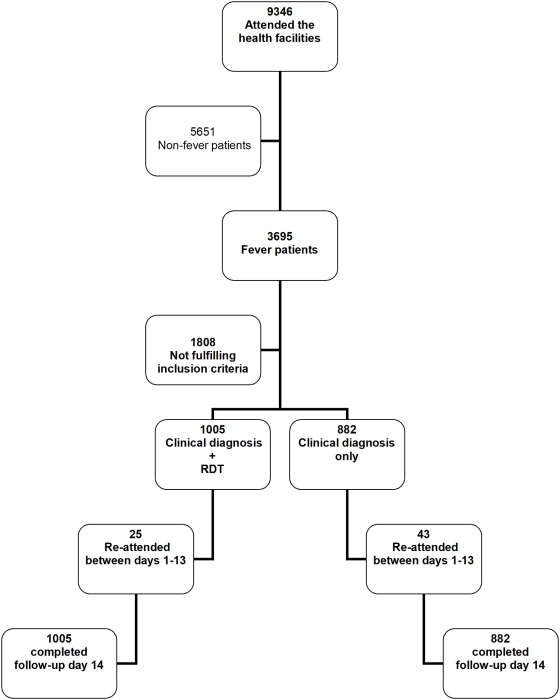
Flow of patients through the trial.